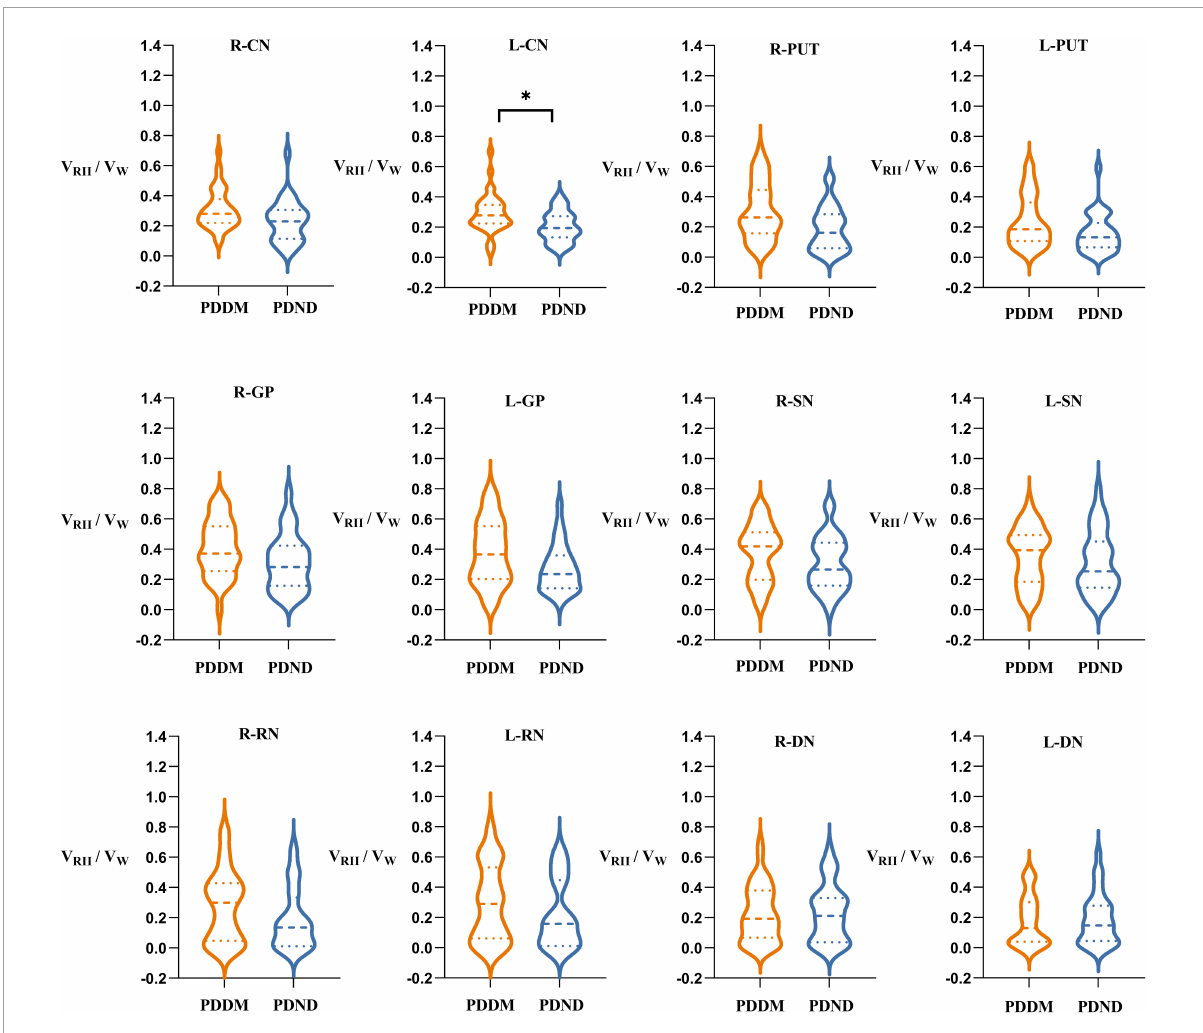
FIGURE3 Comparisons of V RII /V W of gray matter nucleus in brain between PDDM group and PDND group. The results in the figure showed that V RII /V W in the PDDM group were greater than that in the PDND group in most nuclei. There was significant differences in the L-CN. ∗ P < 0.05. V W , volume of the whole nuclei; V RII , volume of the high iron region; PDDM, PD with T2DM; PDND, PD without T2DM; R, right; L, left; CN, caudate nucleus; PUT, putamen; GP, globus pallidus; SN, substantia nigra; RN, red nucleus; DN, dentate